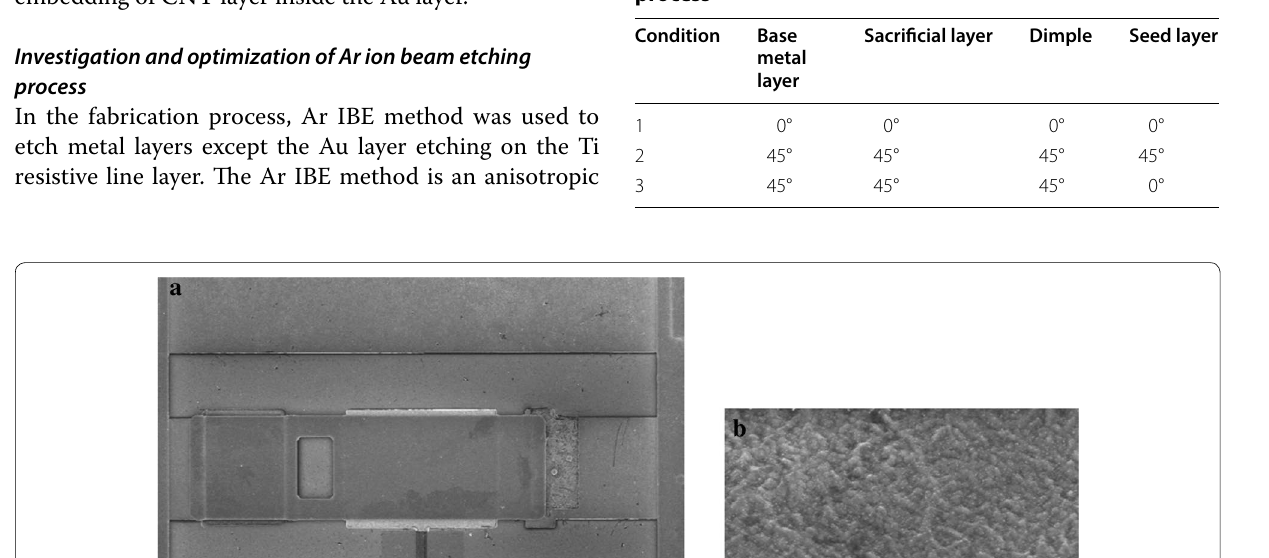
Table 1 Ar ion beam incident angles investigated in Ar